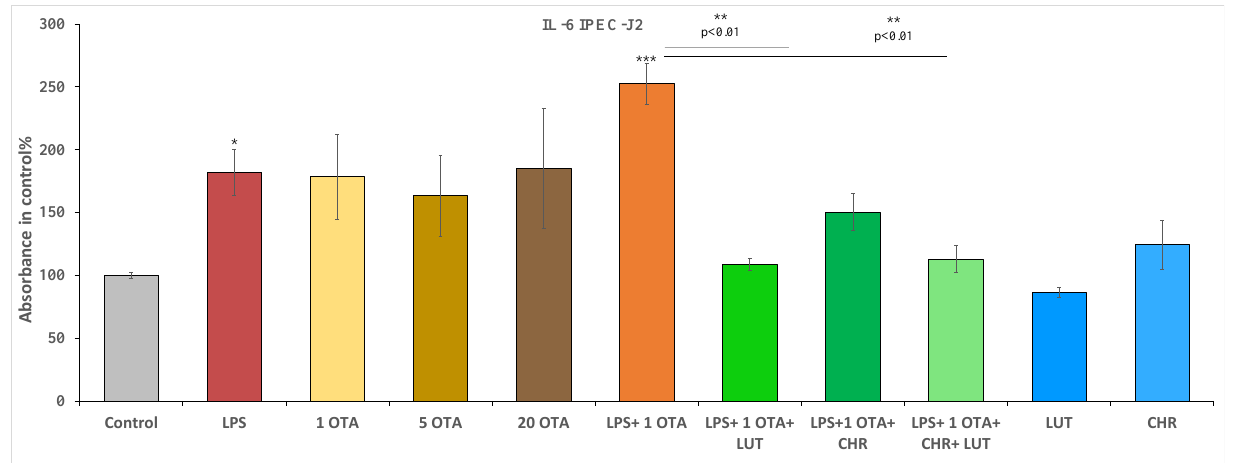
Figure 6. Measurements of interleukin-6 levels after 24 hrs of treatment of IPEC-J2 cells with 1 µM OTA, 5 µM OTA, 20 µM OTA, 1 µM CHR, 8.7 µM LUT, 10 µg/mL LPS and their combinations; data are shown as means of absorbance values with SEM; n = 3 samples per group; * is p < 0.05, ** and *** indicates p < 0.01 and p < 0.001, respectively. Asterisks alone indicate significant differences between control and treated groups, asterisks with p values underlined show significant changes between the designated groups.